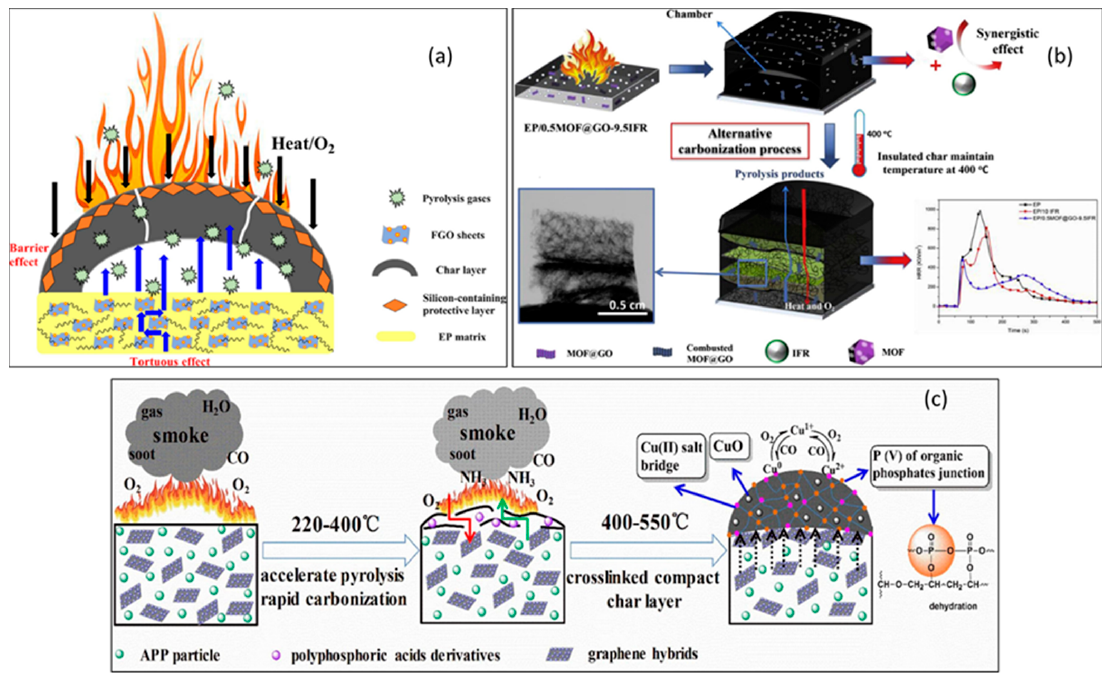
Figure 9. ( a ) Flame-retardant mechanisms in FGO/EP. Reprinted with permission from [87] 2020, Eur. Polym. J. ( b ) an EP-composite flame-retardant-mechanism model. Reprinted with permission from [88]. 2019 Carbon and ( c ) graphene-based EP/APP composites with flame-retardant mechanisms. Reprinted with permission from [89]. 2019, Compos. Part B Eng.